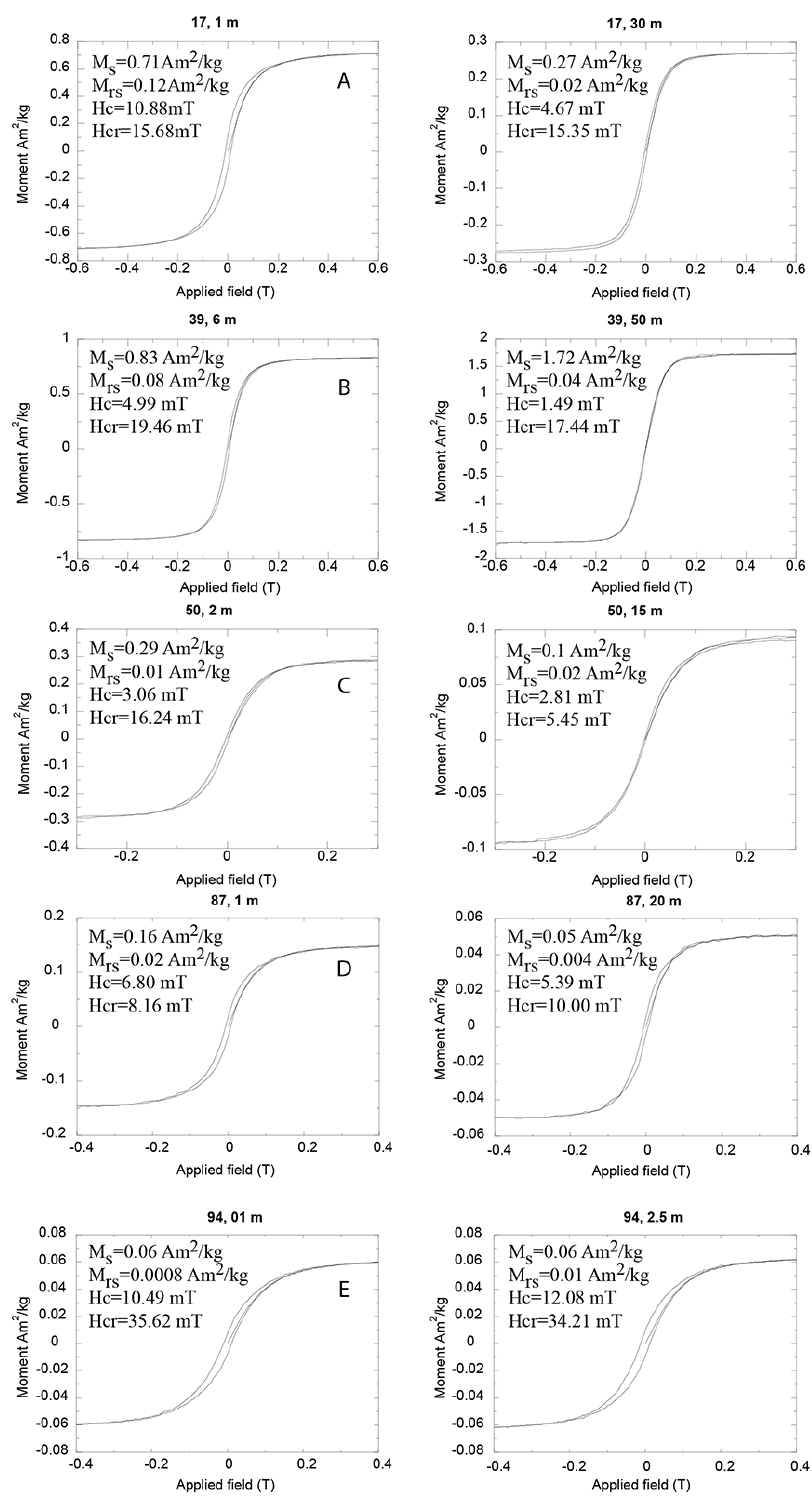
Figure 4. Representative hysteresis curves for each site (A-J). First column is relative to the samples taken nearby the road border, second column refers to the samples off the road